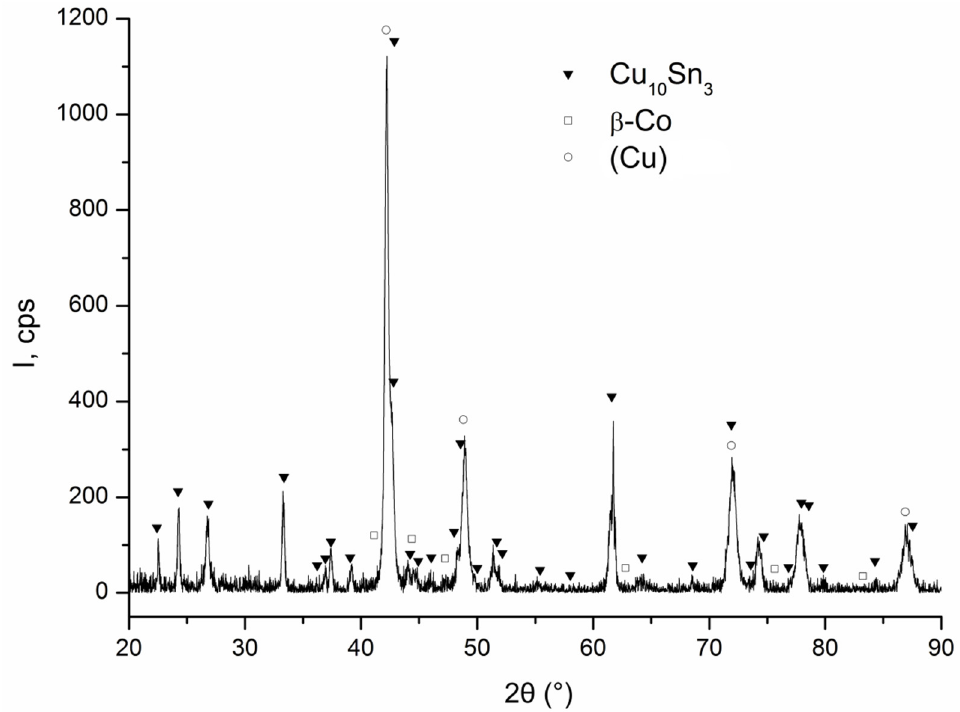
Figure 4. X-ray diffraction pattern of the metallic binder Sn-Cu-Co sintered at 820 ◦ C. In the materials sintered at 780–820 ◦ C, the solid solution (Cu) occurs in the form of more than 4–11 µ m long particles of the oblong shape. Cobalt particles have an equiaxial shape and a cross dimension of 12–15 µ m. Within the space between the β -Co and (Cu) particles, there is the intermetallic Cu 10 Sn 3 phase containing 2–3% wt. of cobalt. In a sample sintered at 780 ◦ C, the proportion of pores is about 21% of the microsection area (Figure 2). An increase in the sintering temperature to 820 ◦ C helps to reduce the porosity to 9–10%. Figure 5 shows the average porosity values of samples sintered at temperatures of 700, 740, 780, and 820 ◦